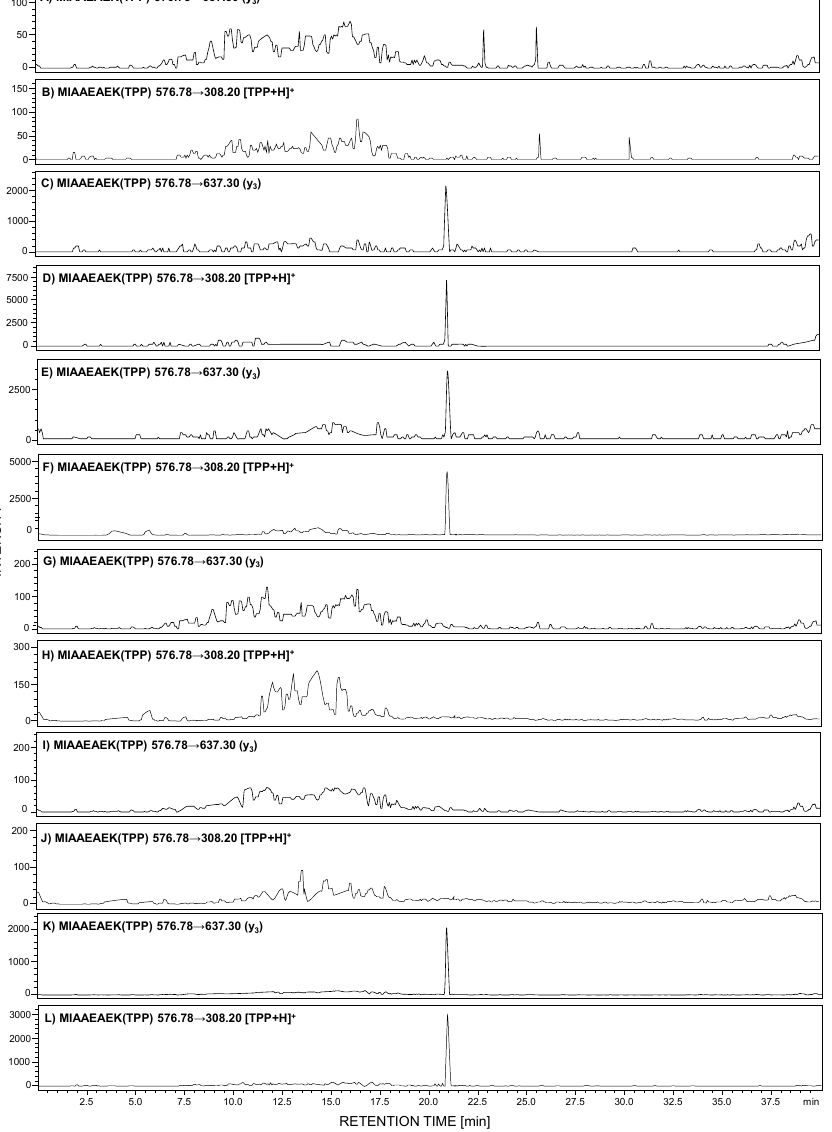
Figure 5. MRM analysis of MIAAEAEK(2,4,6-triphenylpyrylium salt (TPP)) peptide conjugate in tryptic digest of urine sediment samples obtained from healthy patient ( A , B ), patient with PE ( C , D ), MN ( E , F ), FSGS ( G , H ), MPGN ( I , J ), and IgA nephropathy (IgAN) ( K , L ).